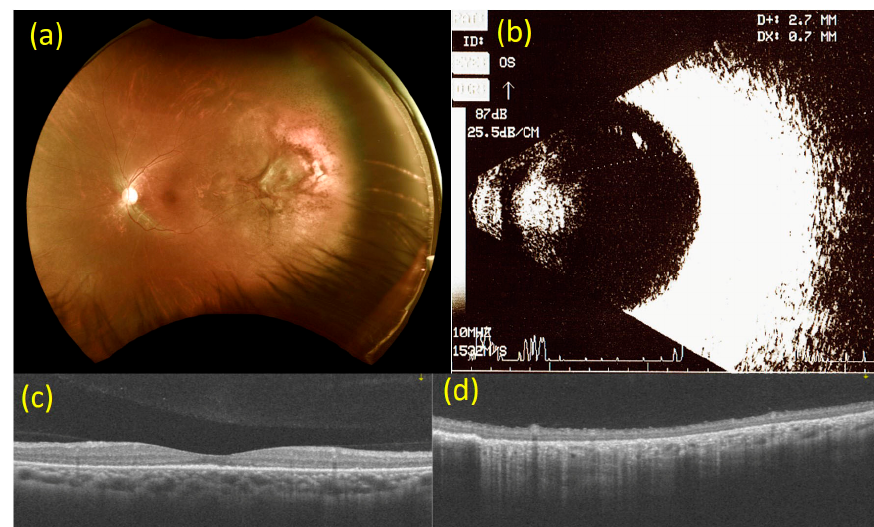
Figure 3. Images from 6 weeks after injection of bevacizumab (2.5 mg). ( a ) Fundoscopy 6 weeks after the injection of bevacizumab (2.5 mg). The white-yellowish spot lesions at the fovea have almost disappeared, and the multiple irregular, ill-defined white lesions at 2 to 3 o’clock on the peripheral side in the left eye have diminished in size. ( b ) B-mode ultrasonography 6 weeks after the injection of bevacizumab (2.5 mg). A dramatic decrease in the size of the tumor, with an extension of 2.7 × 0.7 mm at the superior temporal side in the left eye. ( c ) Macular optical coherence tomography (OCT) scan 6 weeks after the injection of bevacizumab (2.5 mg). The subretinal elevated solid lesion has regressed at the fovea in the left eye. ( d ) OCT scan of the choroidal mass at 2 to 3 o’clock on the peripheral side 6 weeks after the injection of bevacizumab (2.5 mg). The subretinal fluid collection has regressed at the 2 to 3 o’clock position on the peripheral side in the left eye.